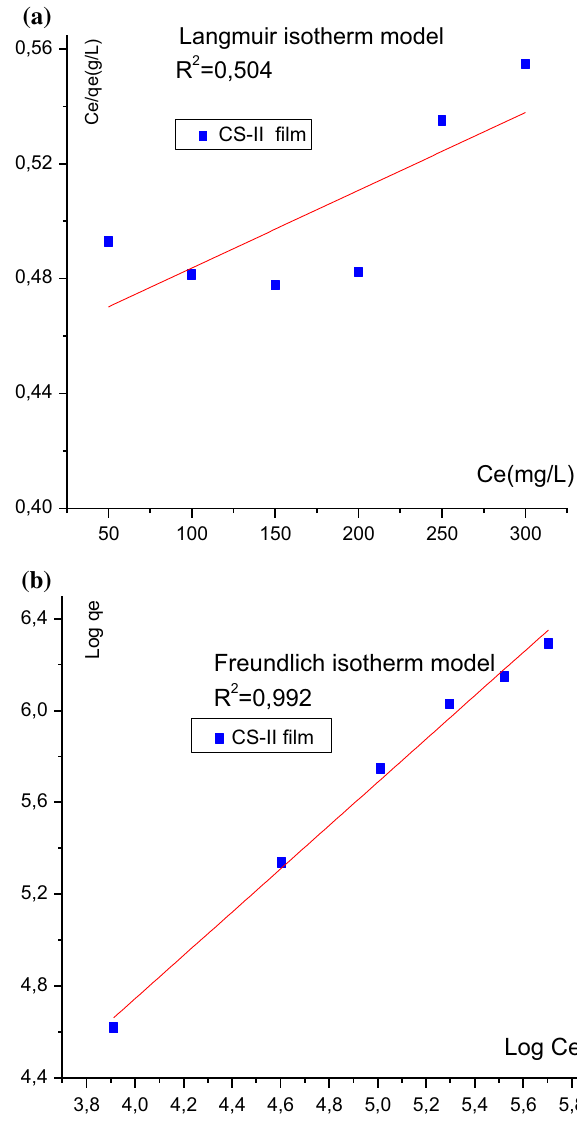
Fig. 9 Adsorption isotherm a Langmuir plot, b Freundlich